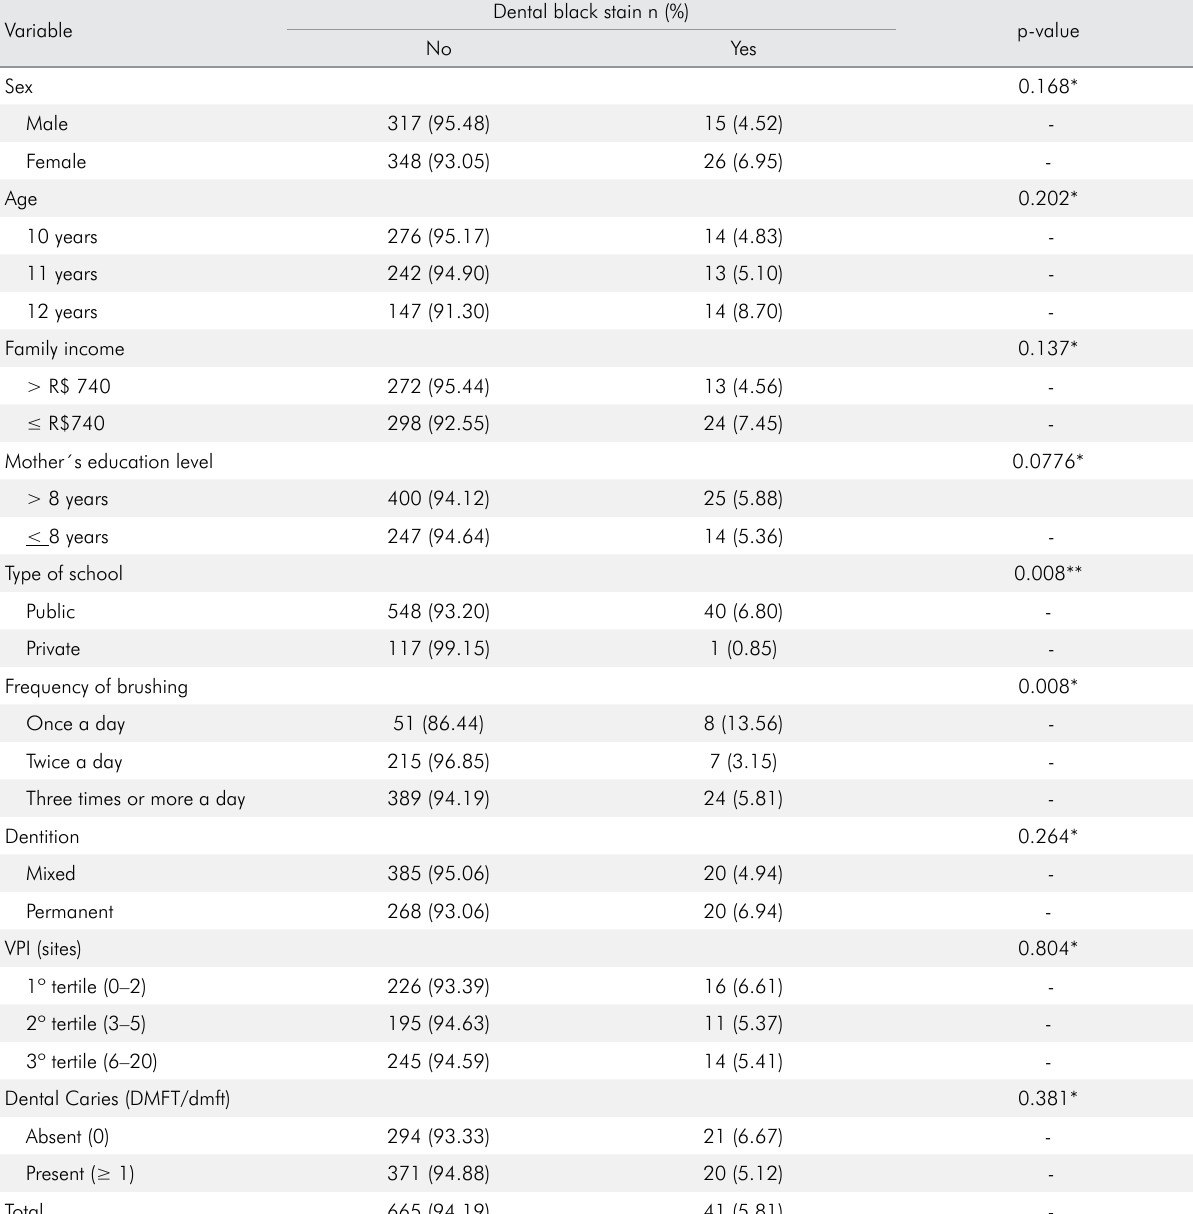
Table 1. Association between independent variables and dental black stain in schoolchildren between 10 and 12 years old. Bivariate analysis. Pelotas, 2010 (n =